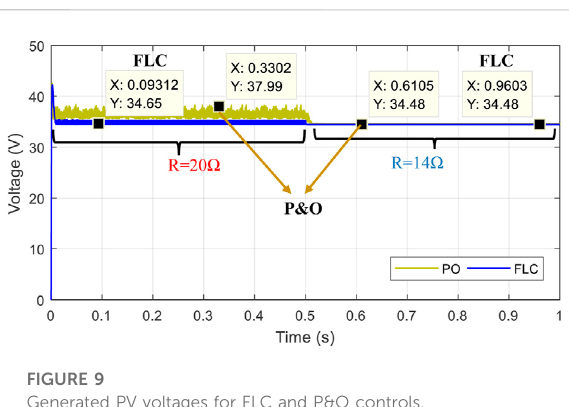
FIGURE 9 Generated PV voltages for FLC and P&O